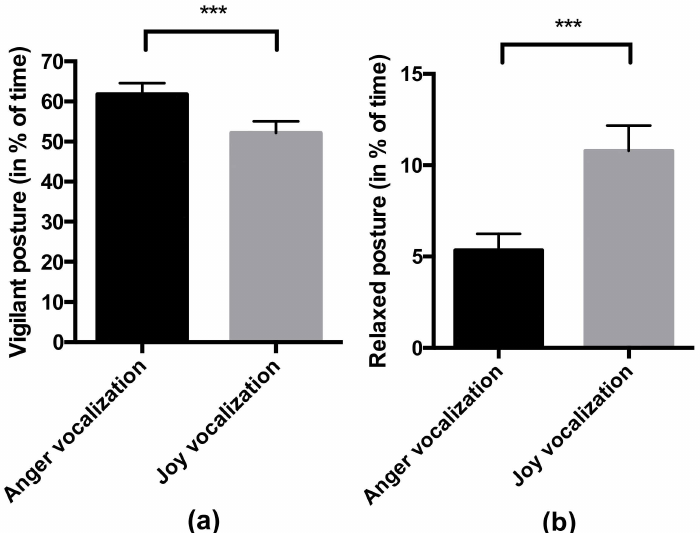
Figure 3. E ff ect of the emotional valence of the vocalization (joy or anger) on the behavior of the horse over the six trials: ( a ) Percentage of time spent in a vigilant posture; ( b ) Percentage of time spent in a relaxed posture. Significance was assessed by a generalized linear mixed model: *** p <